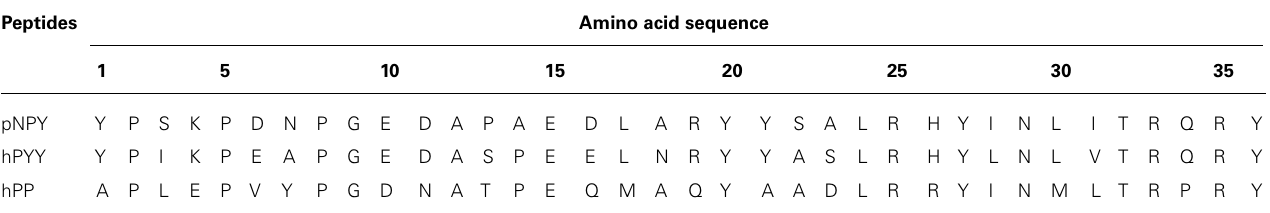
Table 1 |Amino acid sequence of the NPY ligands. Peptides